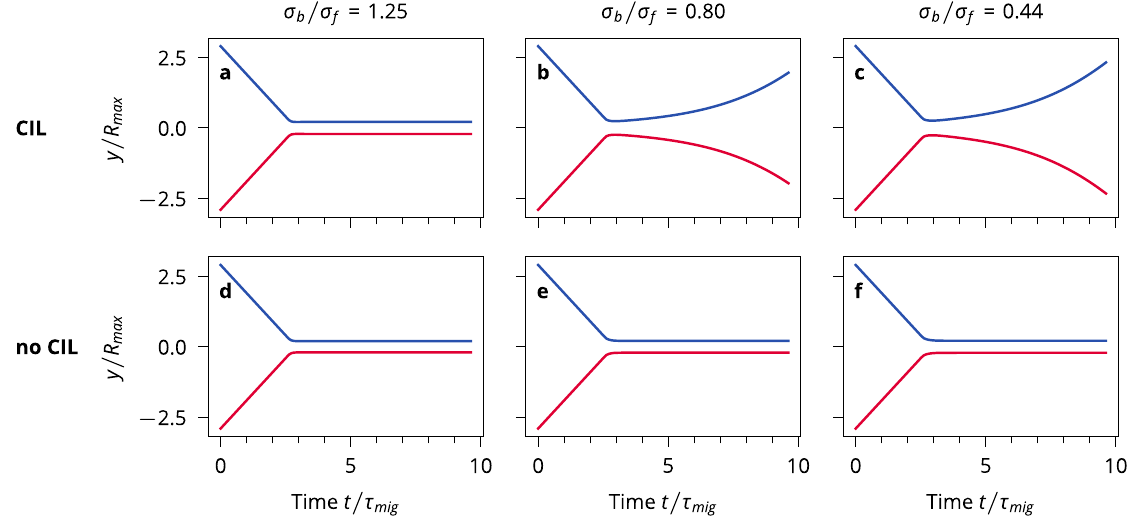
Figure 6. Head-on collisions. Y-coordinates for two cells of the same type colliding with a collision angle of = π , for all the different cell types. θ in